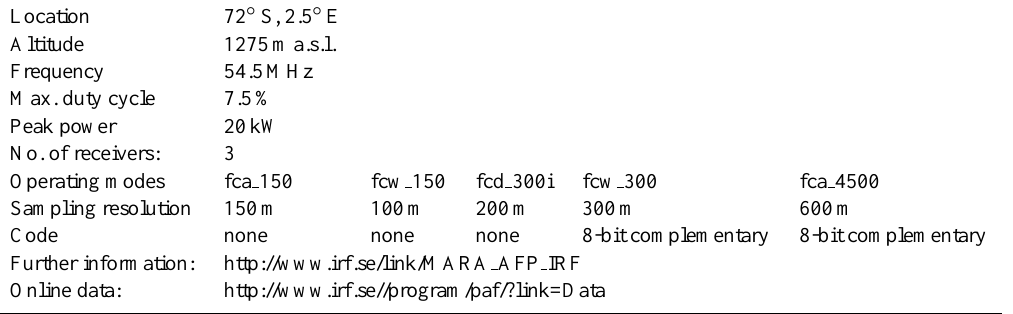
Table 1. MARA: technical details and radar operating modes December 2011–November 2012.